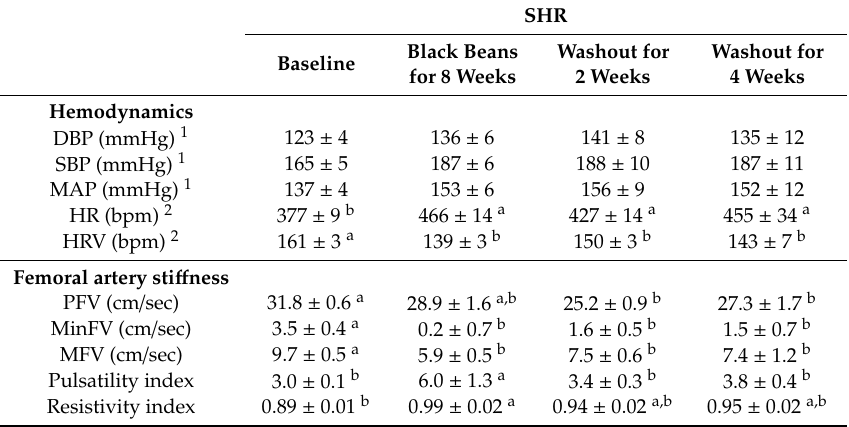
Table 6. Phase 2: Hemodynamic properties and arterial sti ff